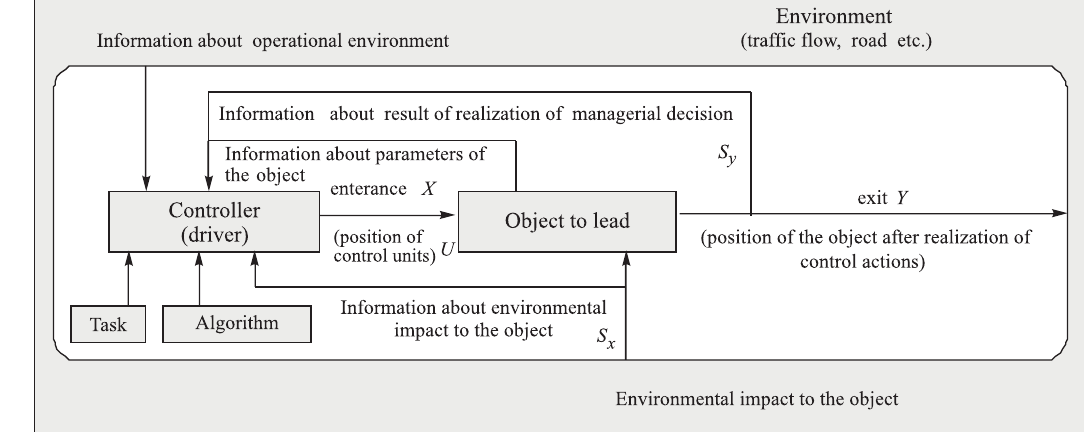
Fig. 1. The process model of the vehicle control system